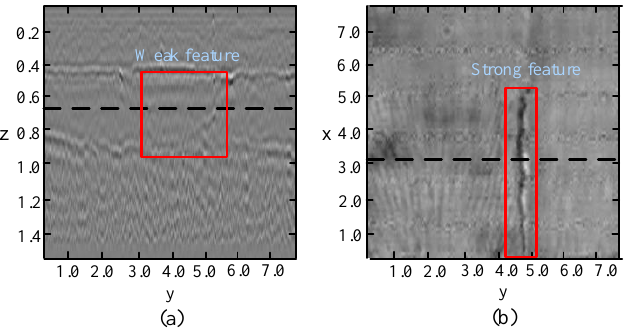
Figure 6. Multi-view scans of a sample defect with a strong feature in the Top-scan and a weak feature in the B-scan: ( a ) B-scan image; ( b ) Top-scan image. Horizon lines in ( a , b ) indicate the depth.